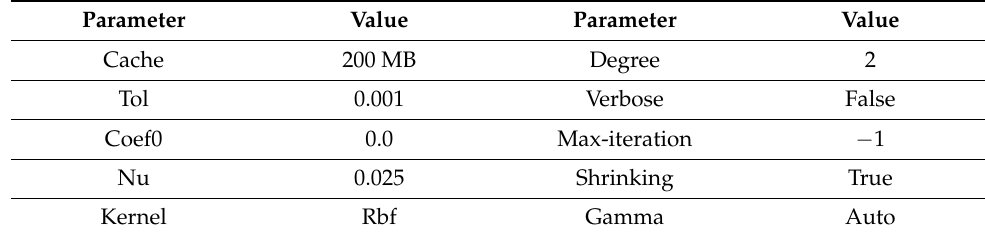
Table 8. Parameter values used in support vector machine.